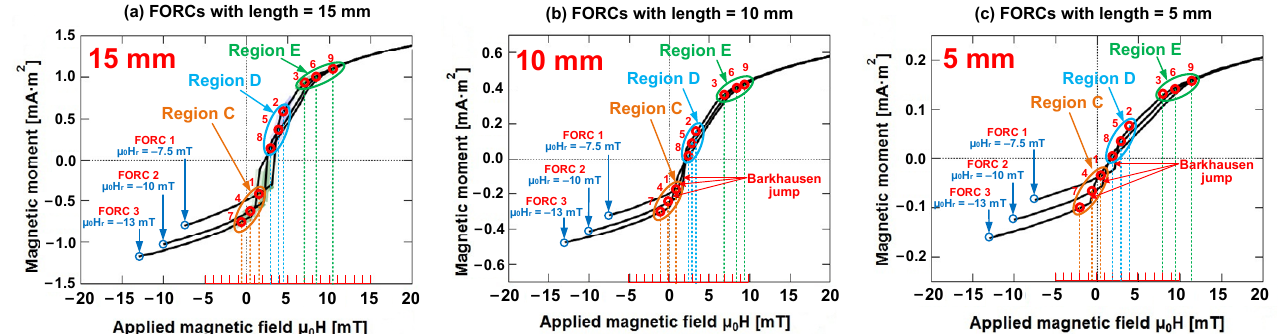
(b) FORCs with length = 10 mm